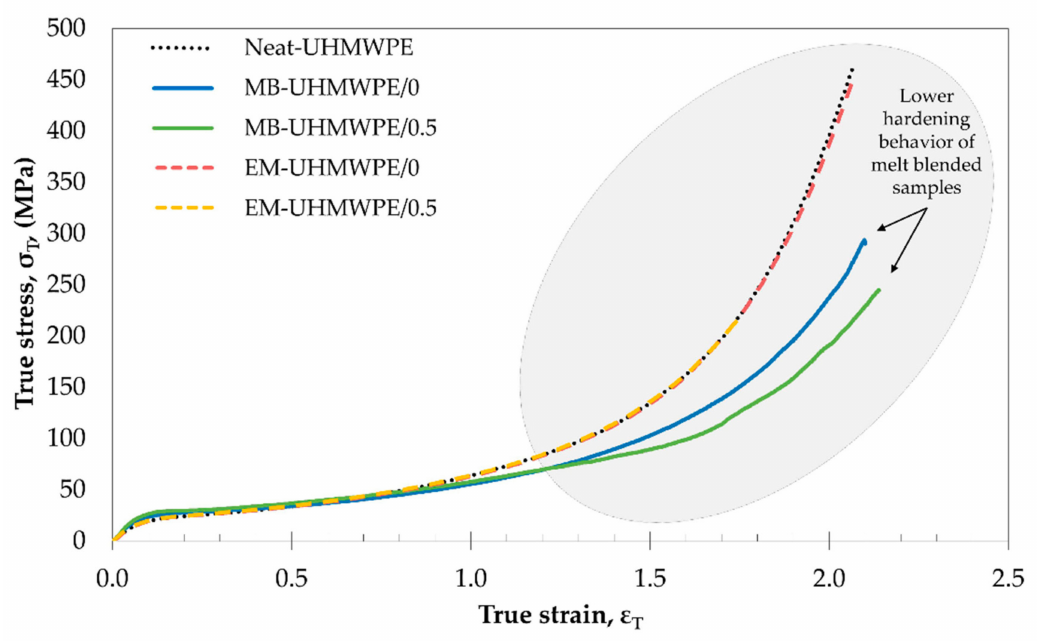
Figure 3. The true stress-strain curve of the neat UHMWPE and UHMWPE/CNF bionanocomposites showing hardening or cold drawing portion behavior in uniaxial